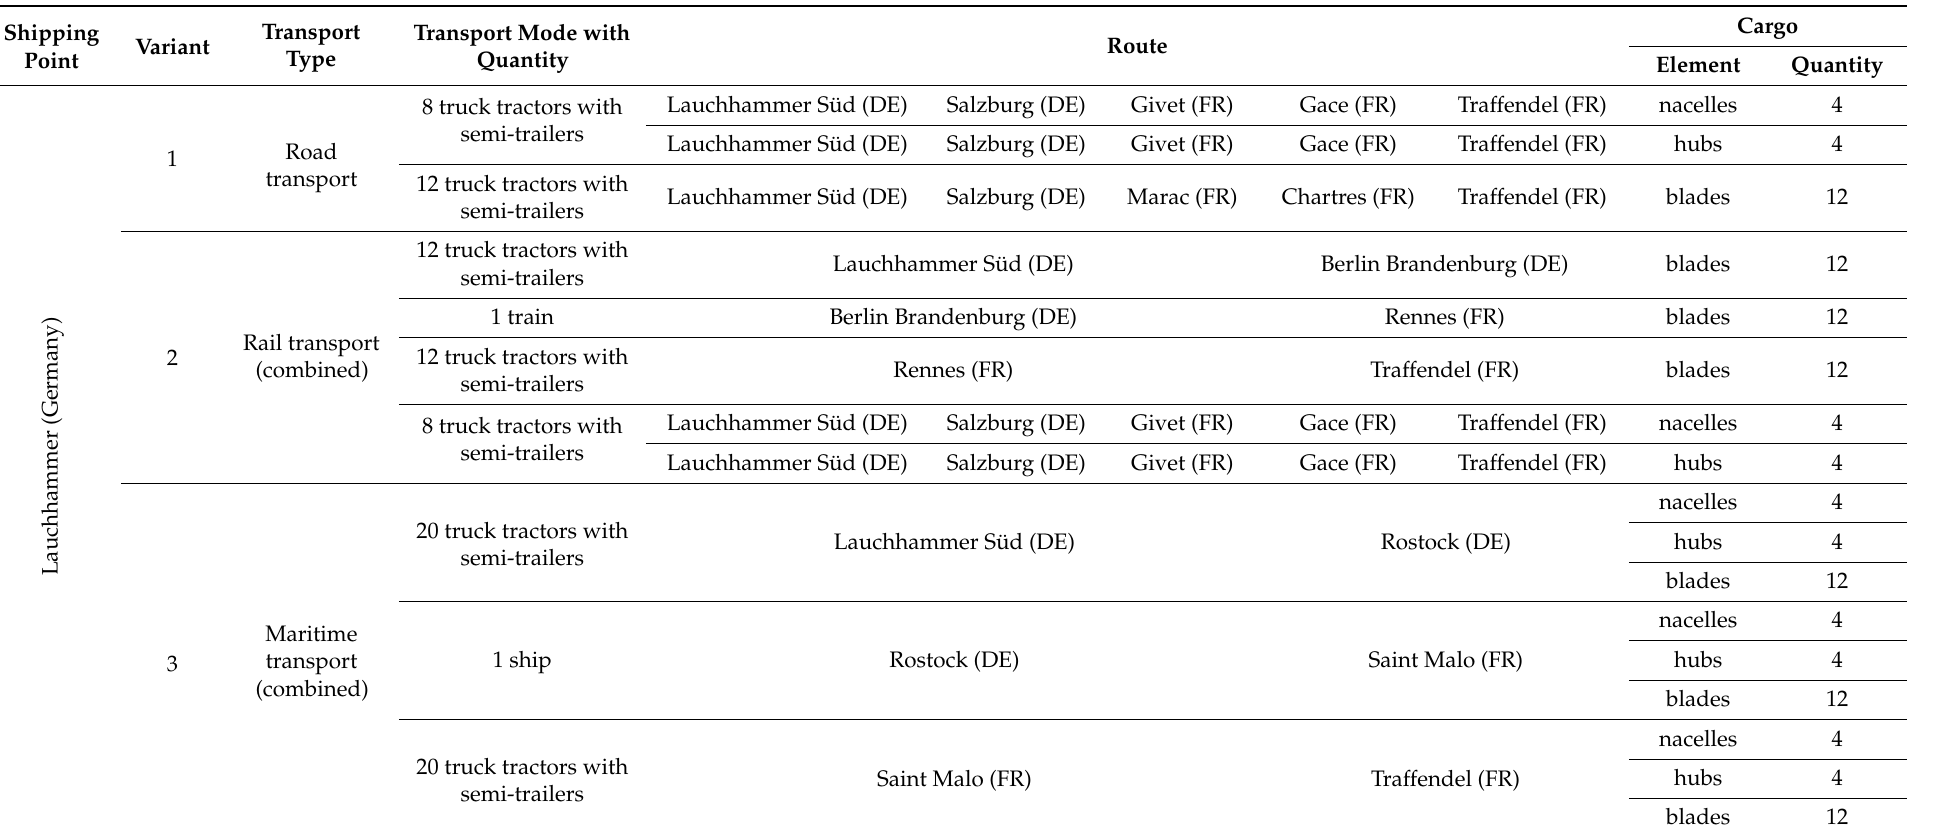
Table 3. Variants of